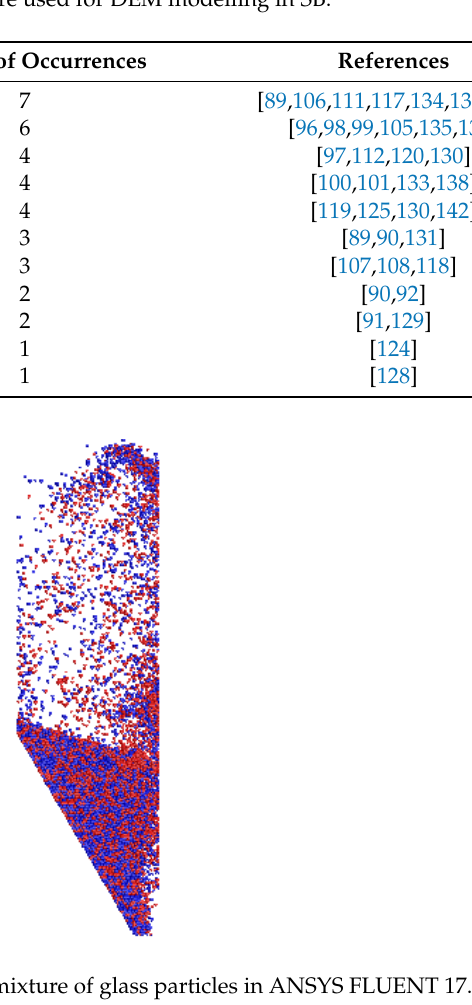
Table 2. Software used for DEM modelling in SB.